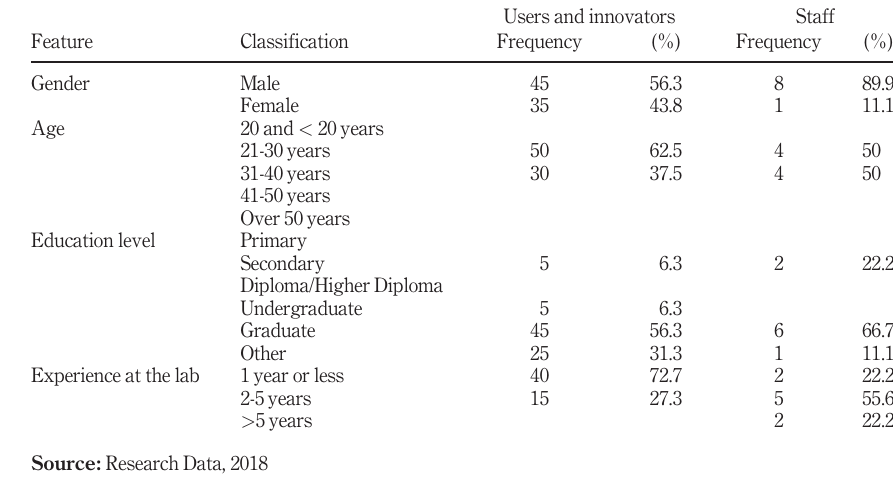
Users and innovators Staff